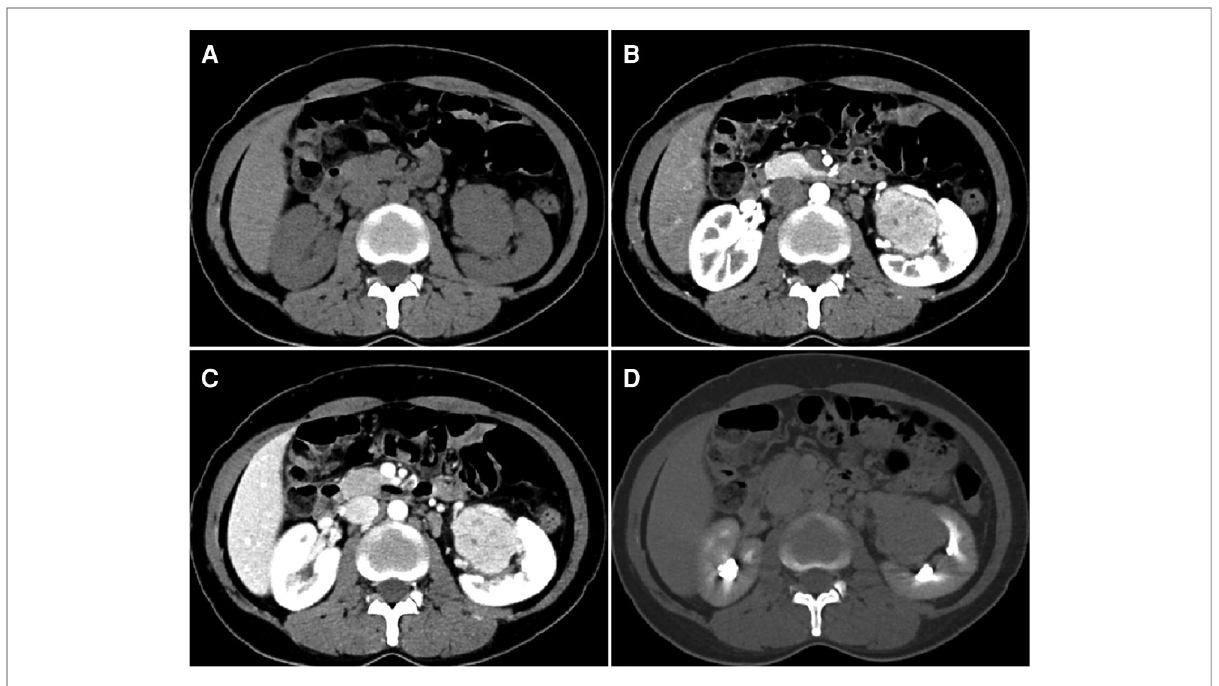
FIGURE 2 CTU reveals a soft tissue mass in the left renal sinus with heterogeneous homogeneous enhancement after injection of contrast media. ( A ) Unenhanced CT scan; ( B ) corticomedullary phase; ( C ) nephrographic phase; ( D ) excretory